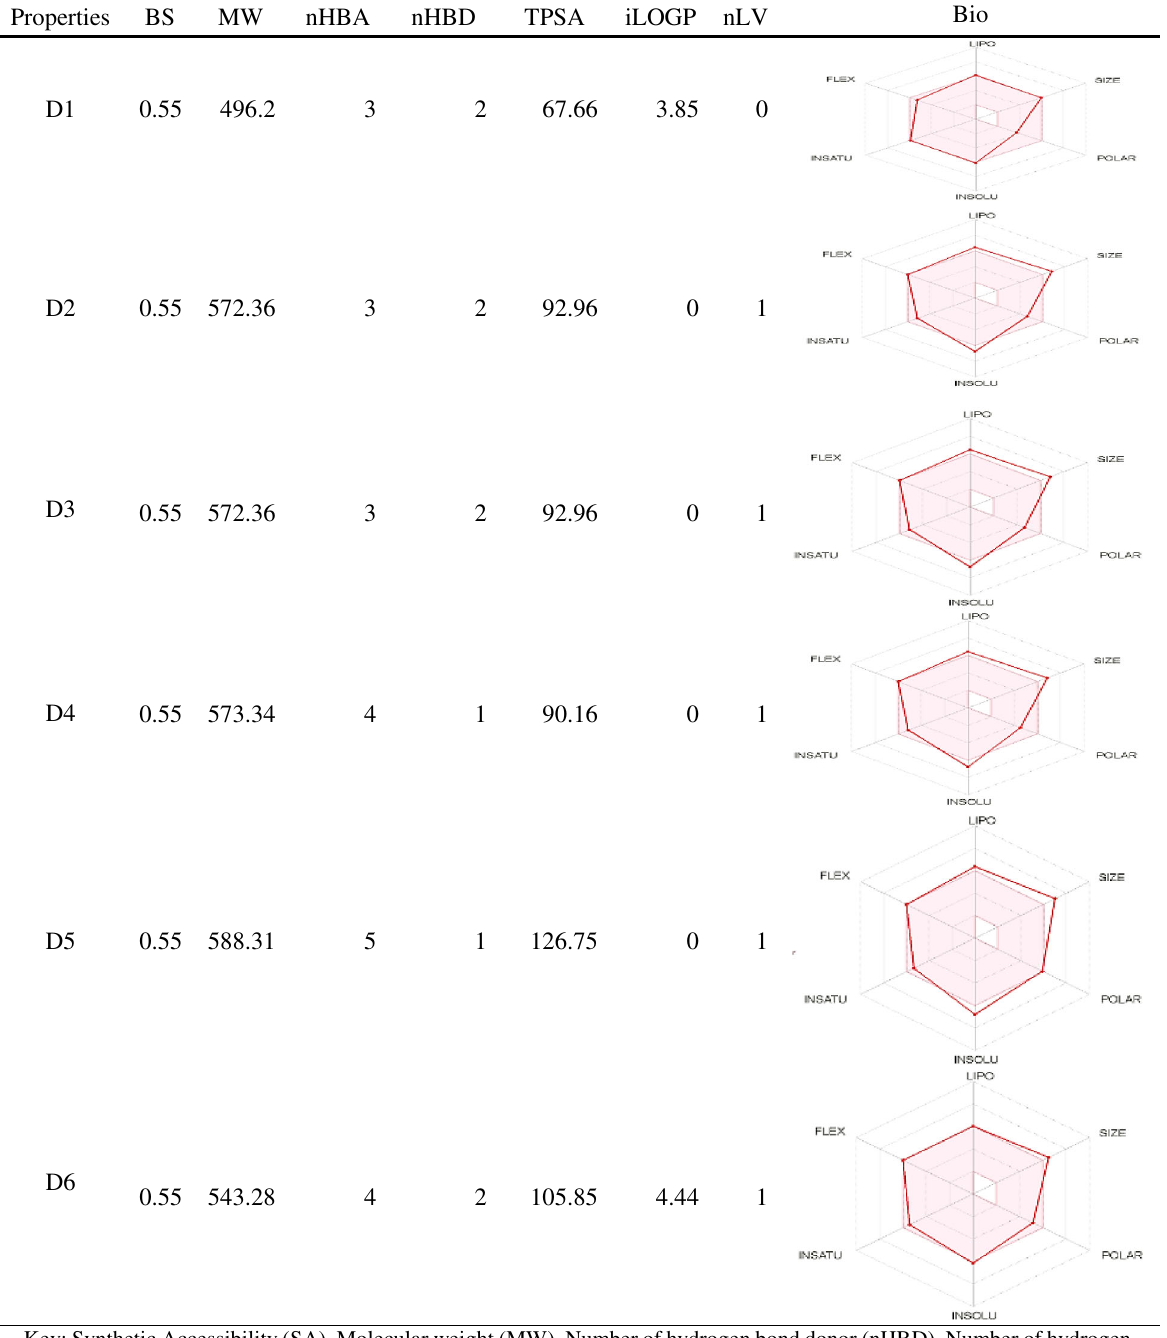
Table 10 ADME and drug-likeness parameters of the designed IPA molecules